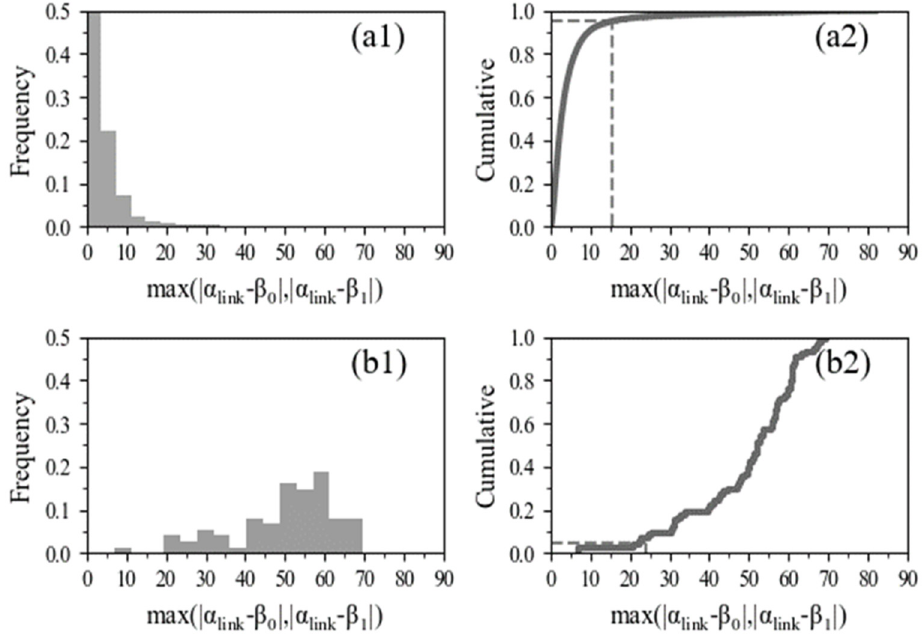
Figure 10. Agreement between two directions, i.e., max ( | α link − β 0 | , | α link − β 1 | ) , is defined to measure the difference between the on-site headings and link direction. ( a1 ) and ( b1 ) respectively show the measured values of the normal and abnormal links and ( a2 ) and ( b2 ) for the cumulative curve, respectively.